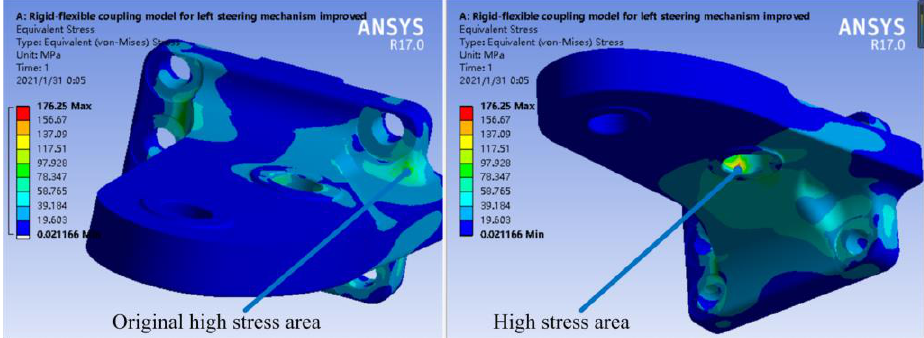
Figure 19. Von Mises stress distribution on the improved steering arm.